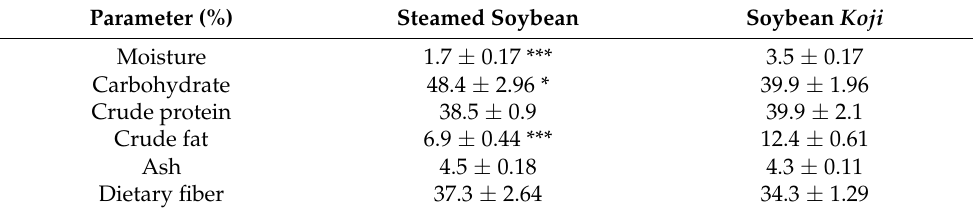
Table 3. Proximate composition of steamed soybean and soybean koji . Parameter (%) Steamed Soybean Soybean Koji Moisture